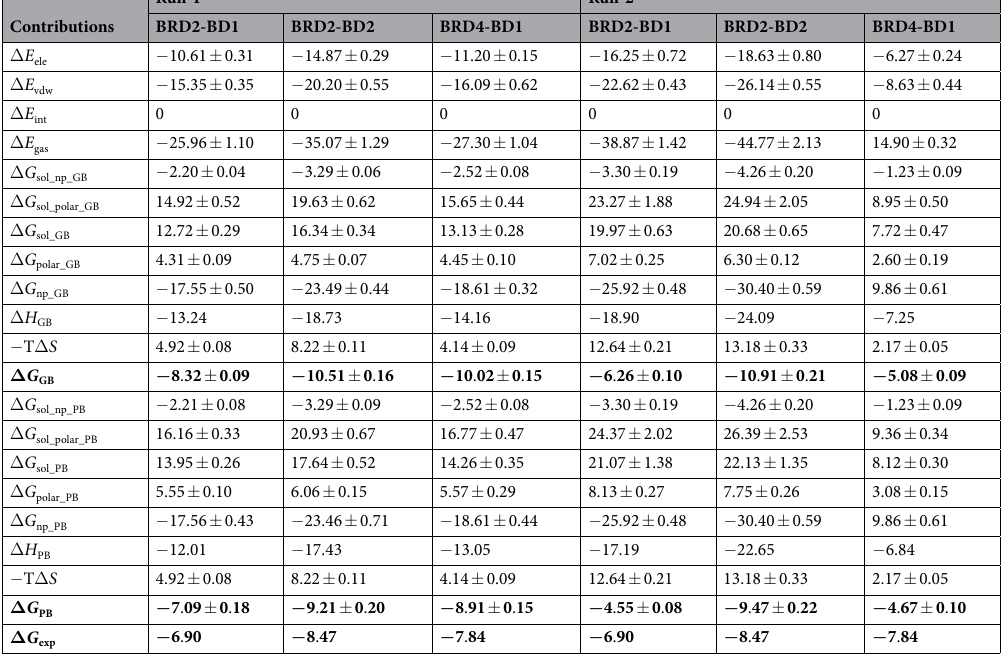
Table 2. The calculated binding free energy and its components (kcal/mol) of three complexes in two parallel